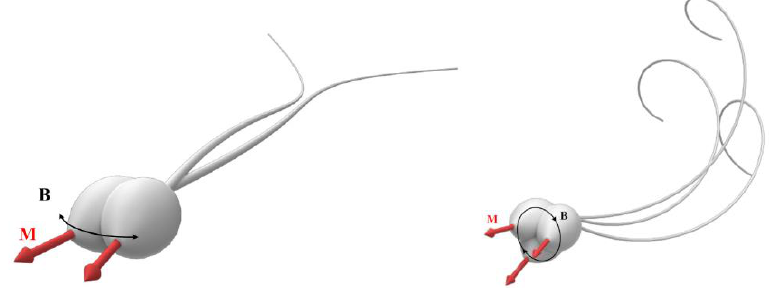
Figure 4. Helical and planar wave propagation initiating mechanisms [88].